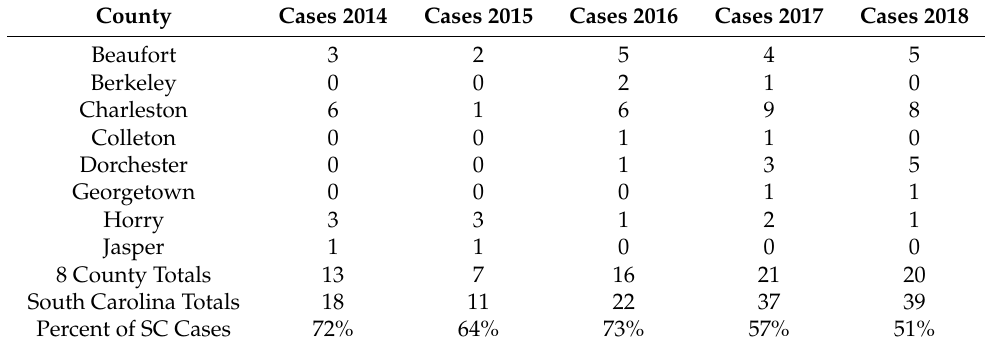
Table A1. The following data on confirmed Vibriosis cases were collected by the CDC’s COVIS monitoring program and obtained via personal communication from Claire Youngblood and Marya Barker [26]. The cases are for the year 2018: the eight coastal or near-coastal counties included in this analysis typically comprise over half of the total cases of Vibriosis in South